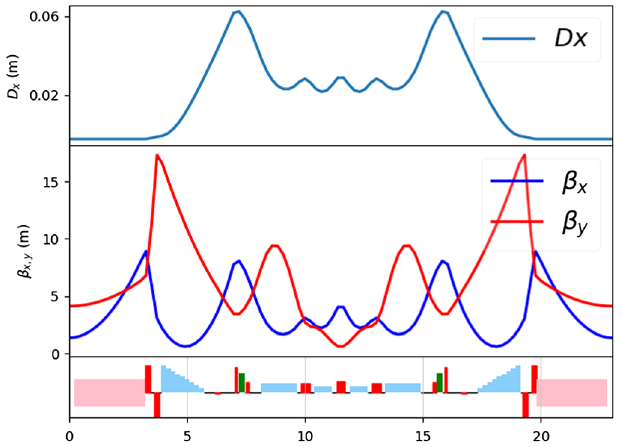
FIG. 2. Possible cell optics for the insertion. The four central bends are combined-function